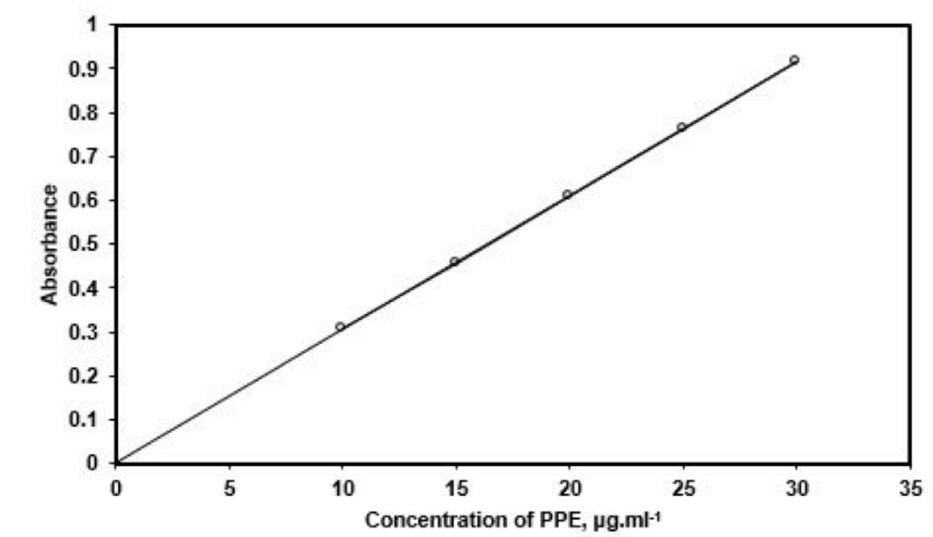
FIGURE 3 - Calibrated curve of perindopril ([PPE] = [4.53×10 -6